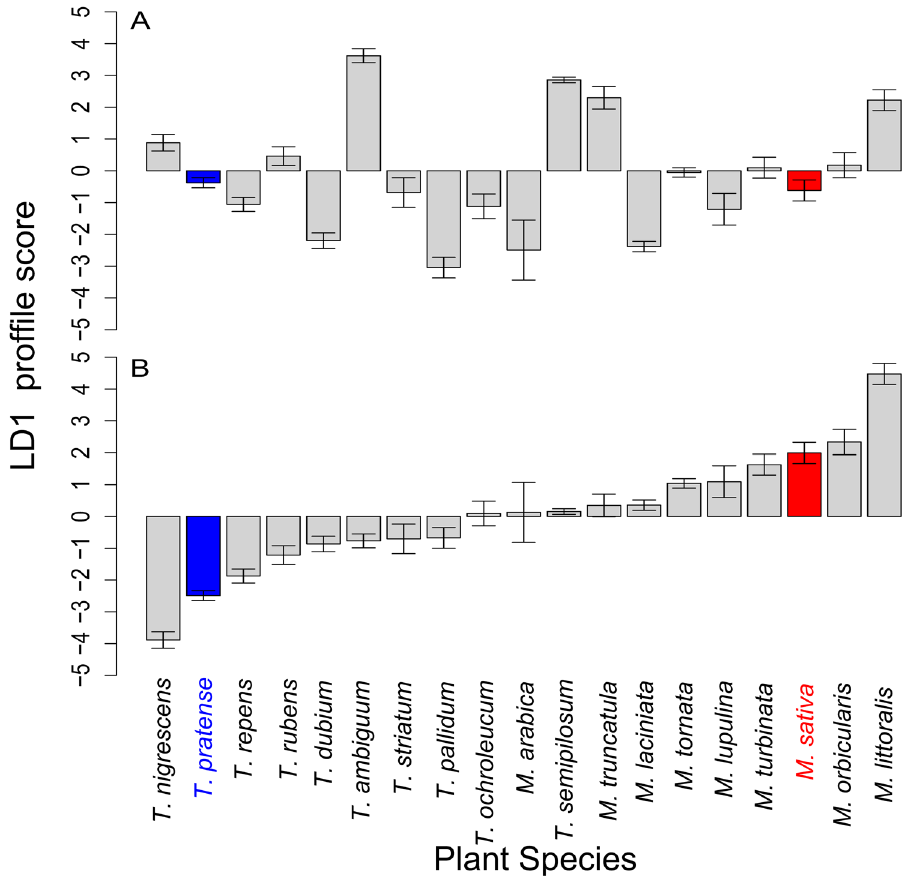
Figure 1. EPG profiles for MS and TP aphids on each plant species. ( A ) Overall acceptance profile with positive LD1 values indicating preference for, and negative values indicating rejection of plants. ( B ) Discrimination profile with positive values indicating greater acceptance by MS aphids and negative values greater acceptance by TP aphids. Red = MS aphid native host, blue = TP aphid native host. There were 2 clones per race, 5–11 replicates per clone and plant species. Mean ±